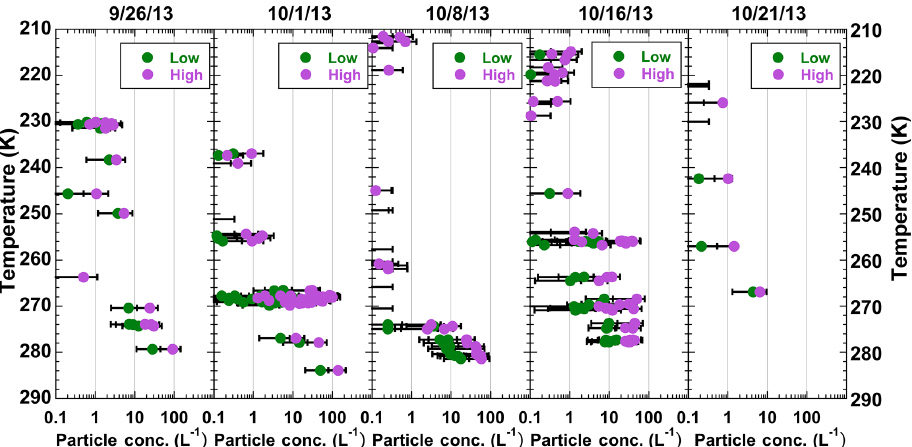
Figure 4. Clear-air temperature profiles of FBAP concentration vs. ambient temperature for each flight. Green and magenta circles are for low and high FBAP values, respectively, based on different definitions of which fluorescent particles are biological as discussed in the text. The top of the boundary-layer inversion varied with flight but was typically at temperatures warmer than 275K.